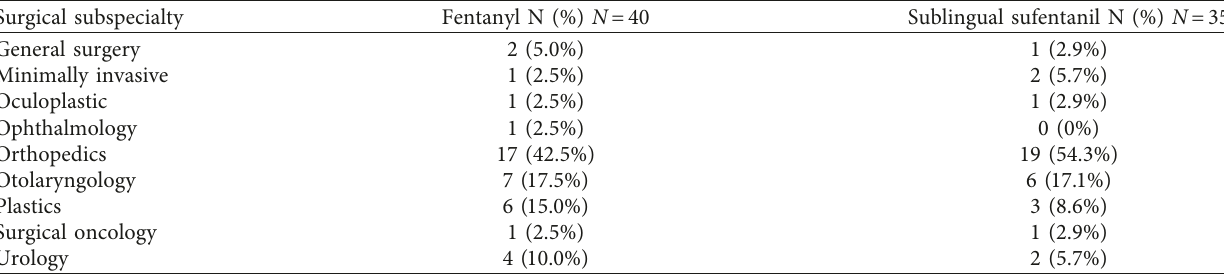
Table 2: Surgical subspecialties enrolled in the study.